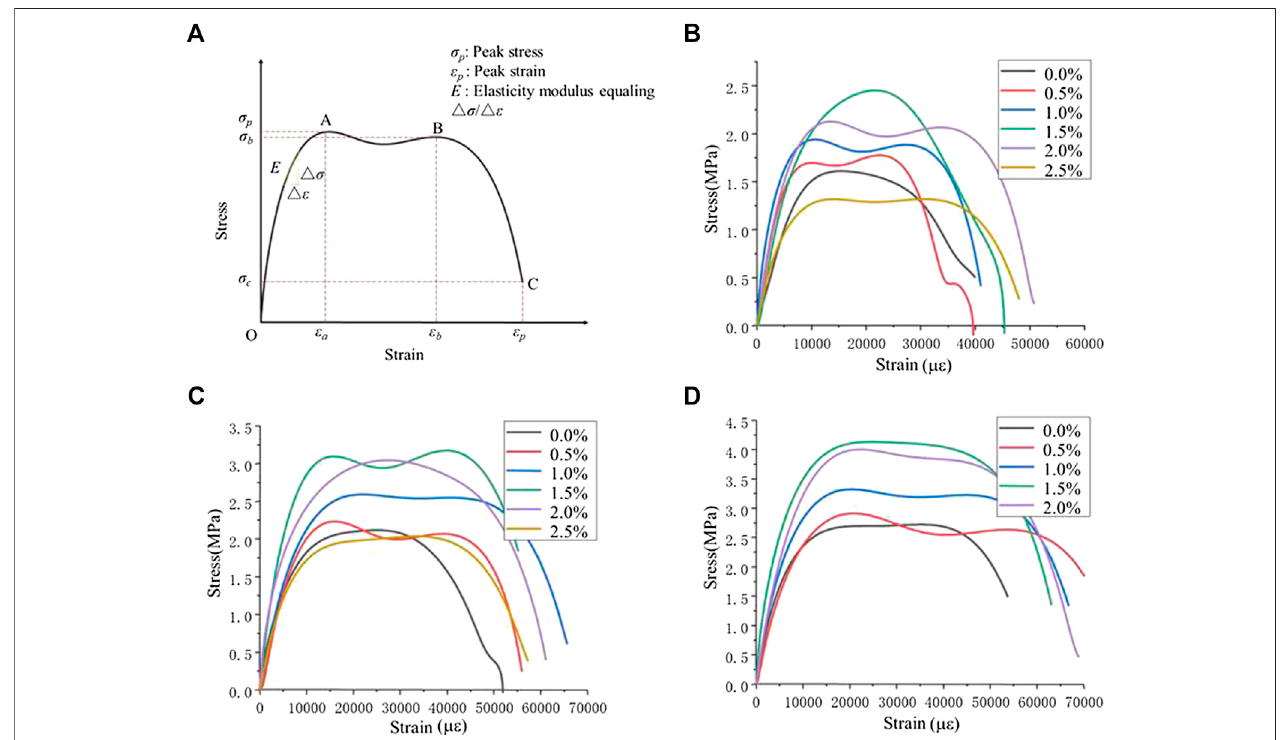
FIGURE 11 | Stress-strain curves (A) Schematic (B) S-S curves at the gas pressure of 0.2 MPa (C) S-S curves at the gas pressure of 0.25 MPa (D) S-S curves at the gas pressure of 0.3 MPa.